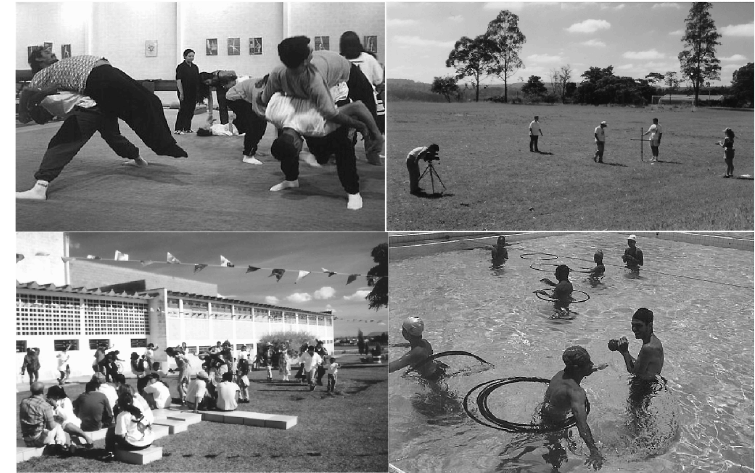
Figura 3. Ambientes do treinamento de